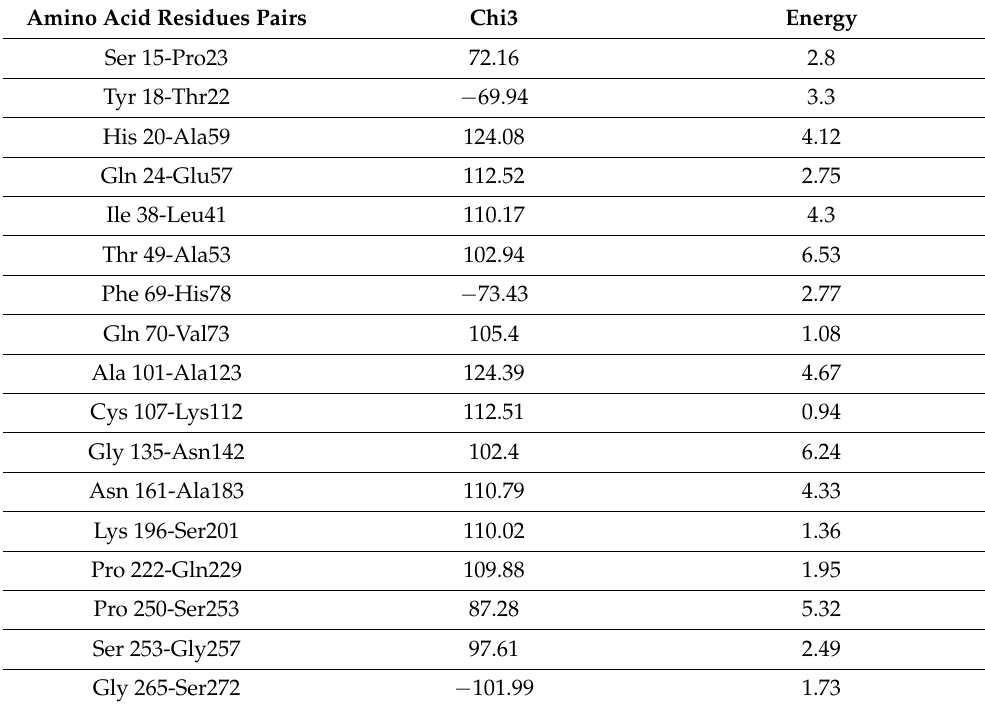
Figure 6. Left side picture represents wild type structure while right side picture represents mutated structure. Table 3. Pairs of amino-acid residues Chi-3 values and energy.